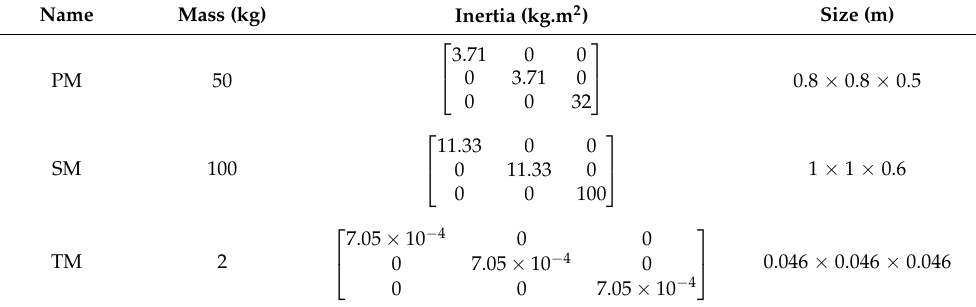
Table 2. Simulation parameters of the improved DFP spacecraft.